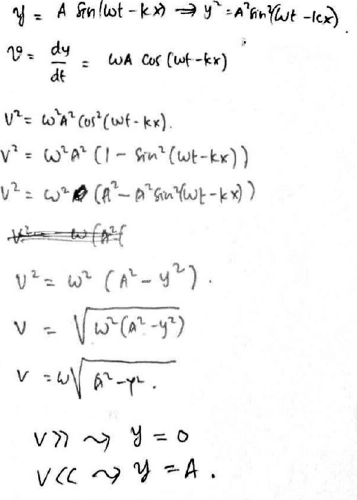
FIG. 4. Johan ’ s derivation of a periodical wave to estimate the magnitude of the